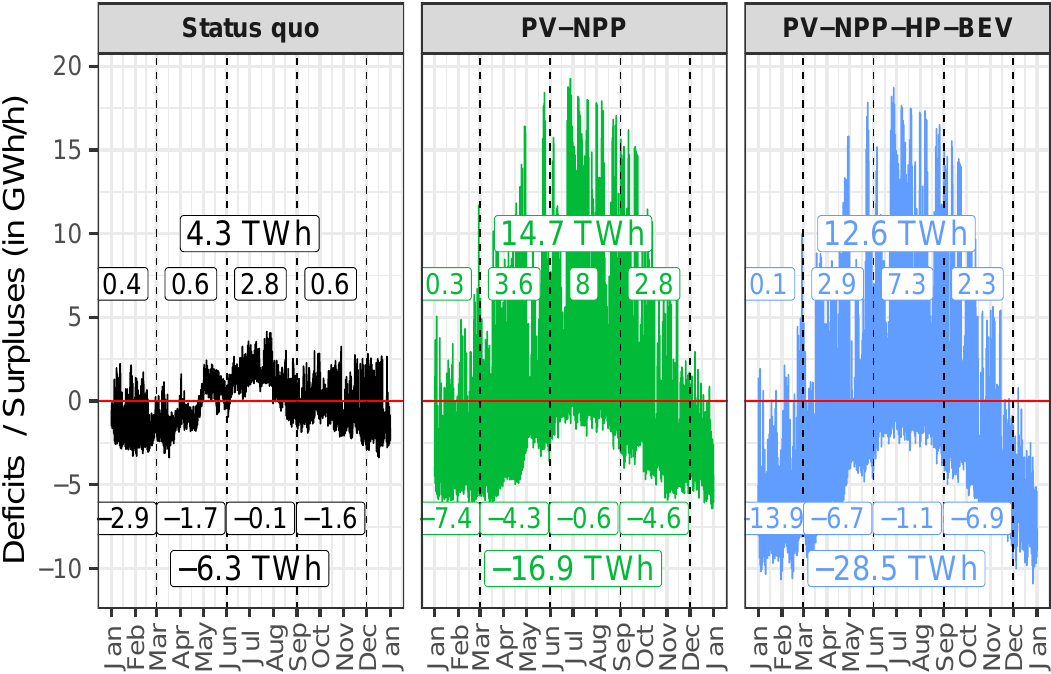
Figure 20. Hours with momentary surpluses (positive values) and deficits (negative values) for the three scenarios in Table 2. Labels indicate seasonal and annual sums of surpluses and